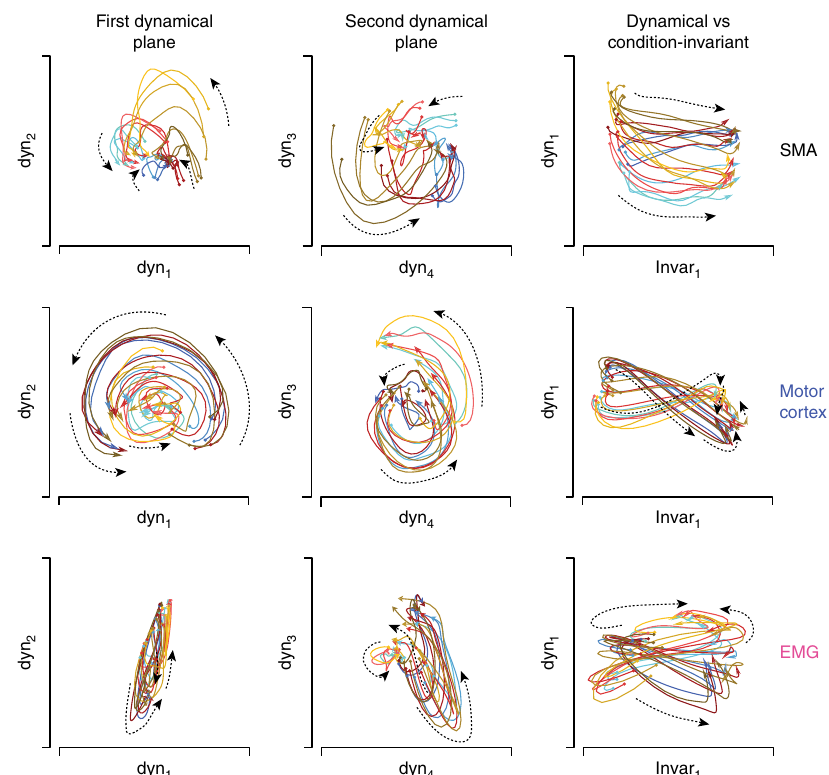
Fig. 5 State-space plots for monkey Ax. Format as in Fig. 4. Scaling is arbitrary but the same scale is always used for the horizontal and vertical axis within each subpanel. Scaling is sometimes altered across subpanels. In particular, for motor cortex, scaling was reduced for the third column to allow plotting of the fi rst condition-independent latent variable, which had a very large